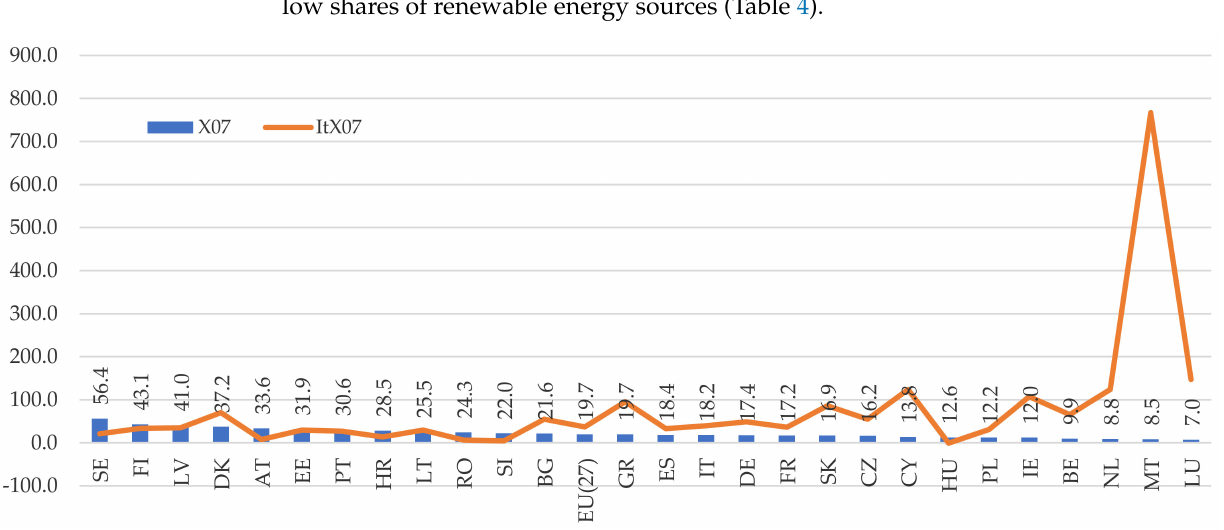
Figure 3. A ranking of EU (27) countries according to the share of total renewable energy in gross final energy consumption in % (X07). in 2019 and index I tX07 for 2019 (2010 = 100). Source: own work based on [76]. Table 4. The share of renewable energy sources in transport (X 08 ), renewable sources of electricity (X 09 ) as well as renewable energy sources in heating and cooling (X 10 ) in EU (27) countries in 2010–2019—statistics. Country Statistics for EU (27) Min